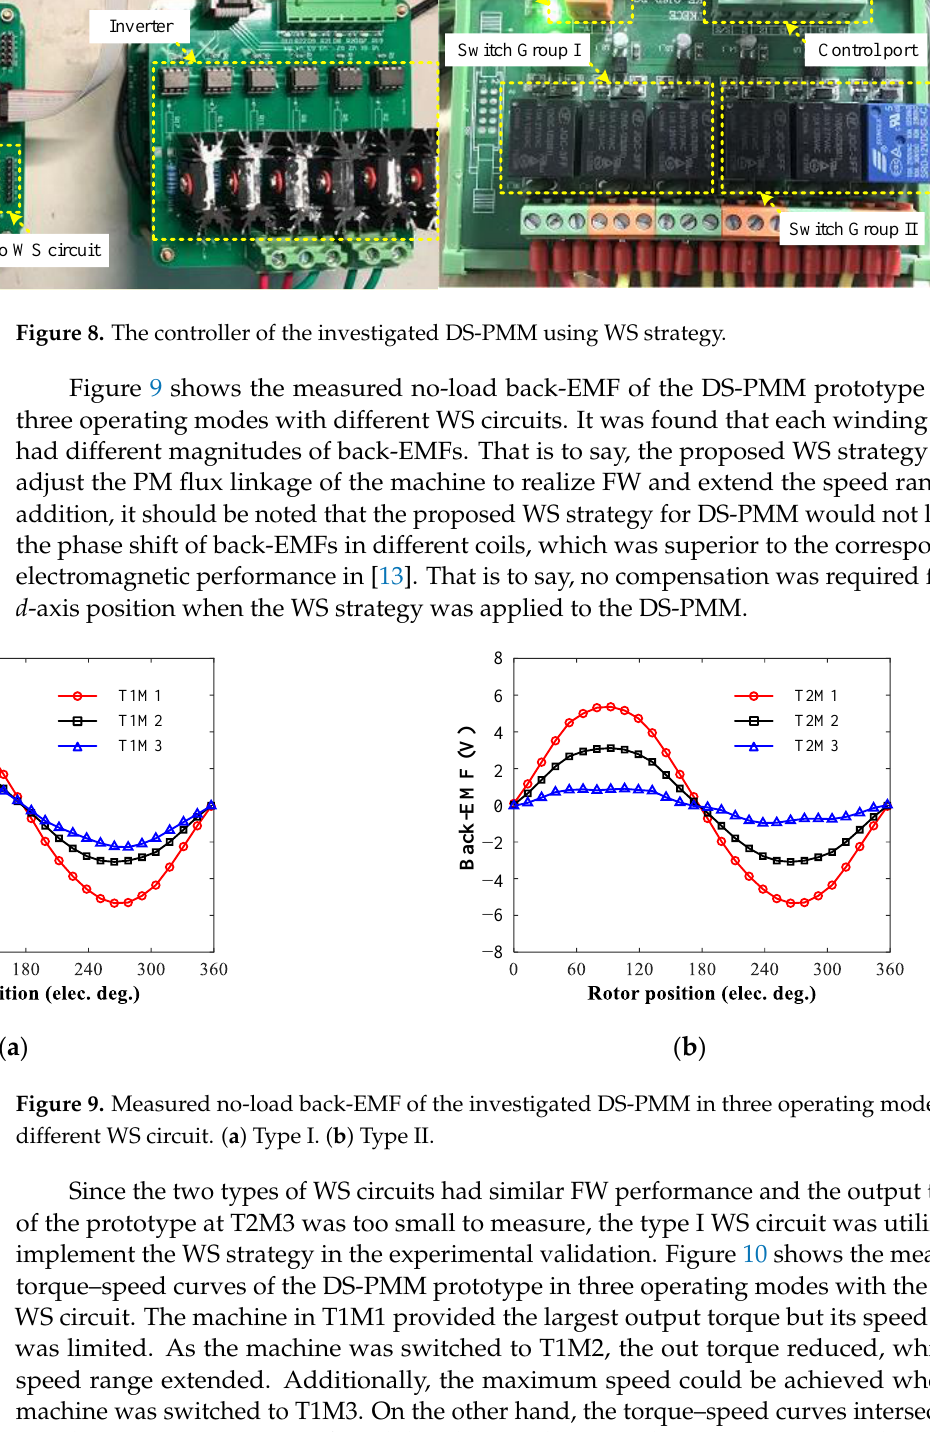
Q Figure 10. Measured torque – speed curves of the DS-PMM prototype in the three operating modes with the type I WS circuit. Figure 11 shows characteristics of the no-load back-EMF during the WS process, and the WS trigger signal indicated the beginning of the switching process. In Figure 11a, the peak-to-peak value of line voltage was reduced from 25.2 V to 14.8 V when the machine was switched from T1M1 to T1M2 at 500 rpm. Similarly, when the machine was switched from T1M2 to T1M3 at 1000 rpm, the line voltage was reduced from 29.4 V to 20.8 V. According to these no-load experimental results, it could be concluded that the WS circuit could realize the winding reconfiguration in 20 m and the proposed WS strategy for DS- PMM had an effective flux adjustment capability.